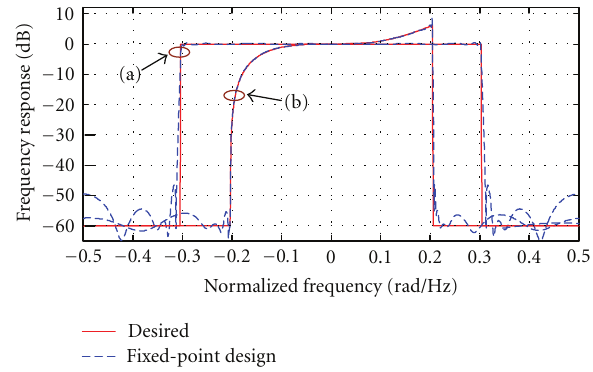
Figure 4: Frequency response of the designed fixed-point filters and the desired